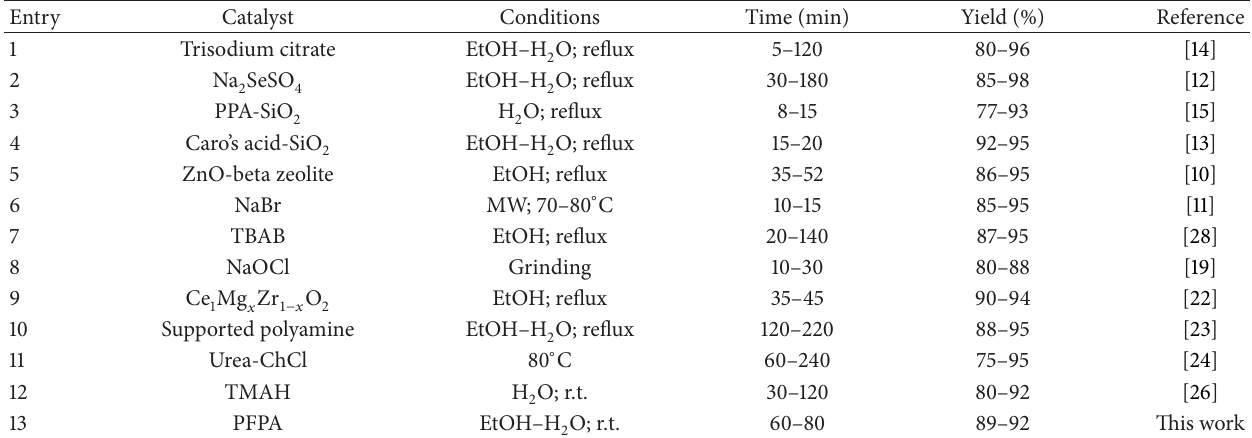
Table 3: Comparison of efficiency of various catalysts in synthesis of tetrahydrobenzo[ b